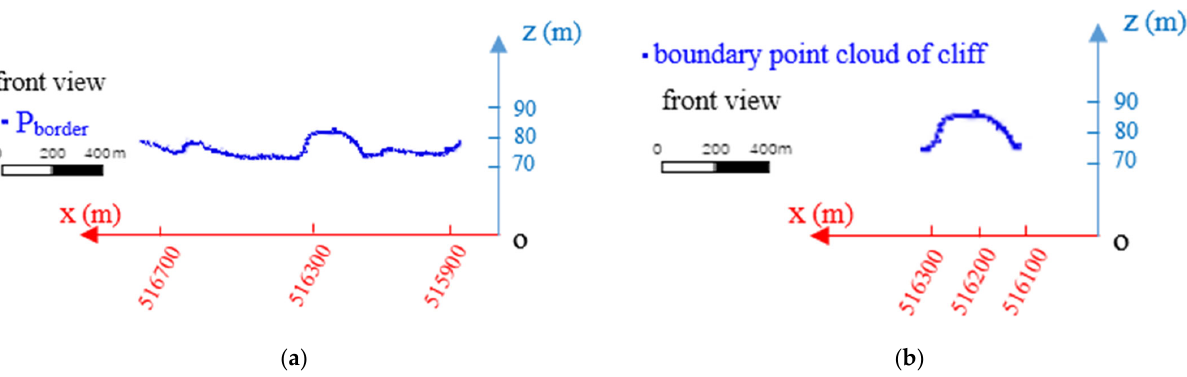
Figure 6. ( a ) Boundary point cloud dataset, P border ; ( b ) Boundary point cloud of cliff section. Among the two junction points, A and B, the point closest to A in the x-direction and with the smallest elevation difference is point C, and the point closest to B in the x-direction, and with the smallest elevation difference is point D. The distance between A, B and C,